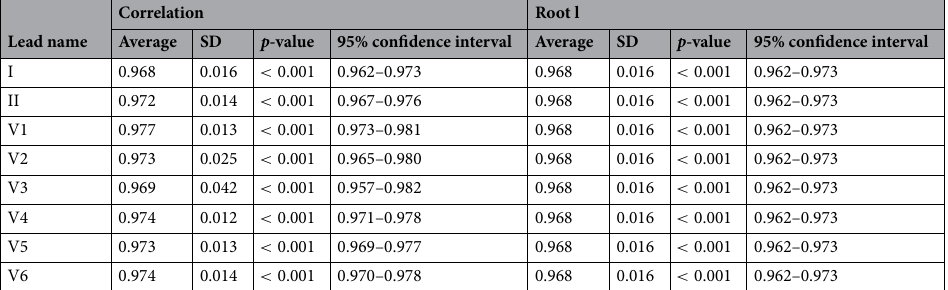
Table 7. Correlation and root mean squared error (RMSE) statistics of the digitised results from 44 printed and scanned paper ECGs and the ground truth digital ECGs (validation